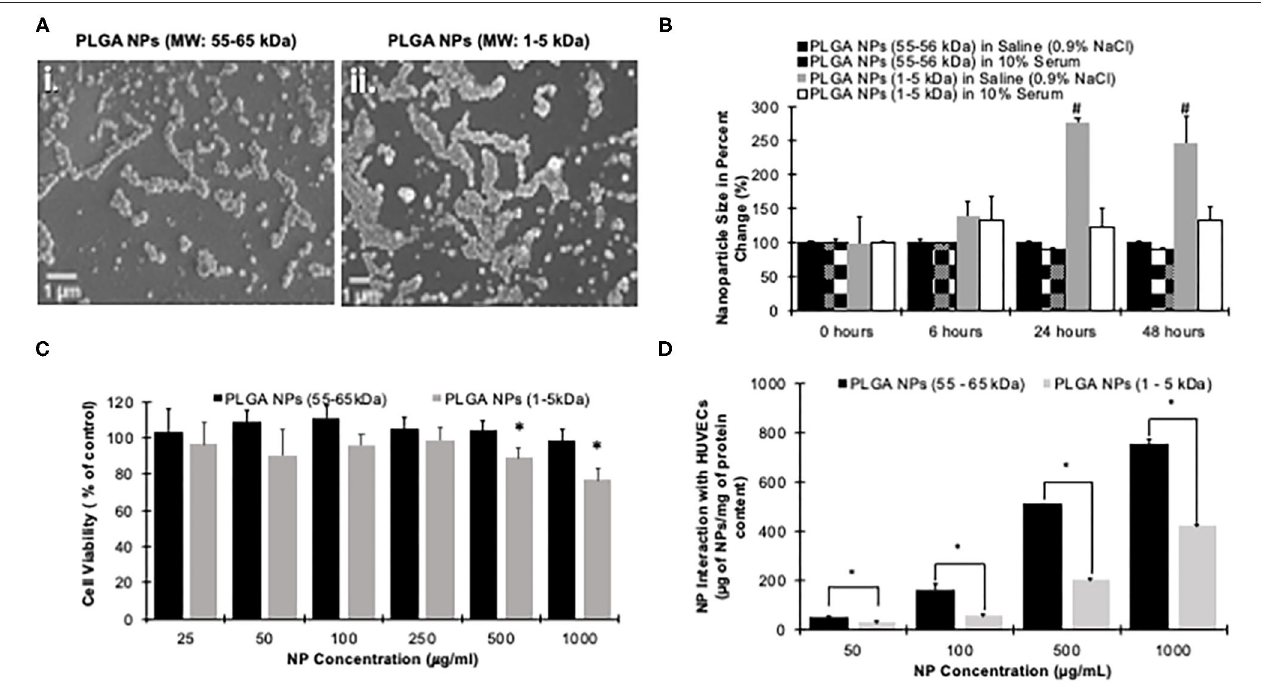
FIGURE 2 | Characterization of PLGA nanoparticles. (A) SEM images of (i) PLGA at 55–65 kDa and (ii) PLGA at 1– 5 kDa nanoparticles. Aggregation occurs during the air-drying process due to the shrinking water droplet on the glass slide for taking this images. Scale bar is 1 µ m. (B) Nanoparticles stability in saline (0.9% NaCl) or 10% Serum over time shows that the HMW PLGA nanoparticles’ size is steady in both solutions, while the LMW PLGA nanoparticles vary in both the Saline and 10% Serum. Error bars denote standard error. #Indicates a significant difference from the samples’ time point 0 ( p < 0.05) evaluated via one-way ANOVA. (C) Cytocompatibility test comparing HMW to LMW PLGA nanoparticles. This shows at all concentrations the HMW PLGA nanoparticles are insignificantly toxic to the cells. The LMW nanoparticles are tolerated up to a concentration of 250 µ g/mL. *Indicates a significant difference from 100% viability evaluated via two-way ANOVA ( p < 0.05). (D) HUVEC uptake of both HMW and LMW PLGA nanoparticles shows HMW had significantly higher uptake than LMW at all tested concentrations. Data shown as mean + standard error. *Indicates a significant difference between HMW and LMW Nanoparticle uptake evaluated at each time point via a t -test ( p <